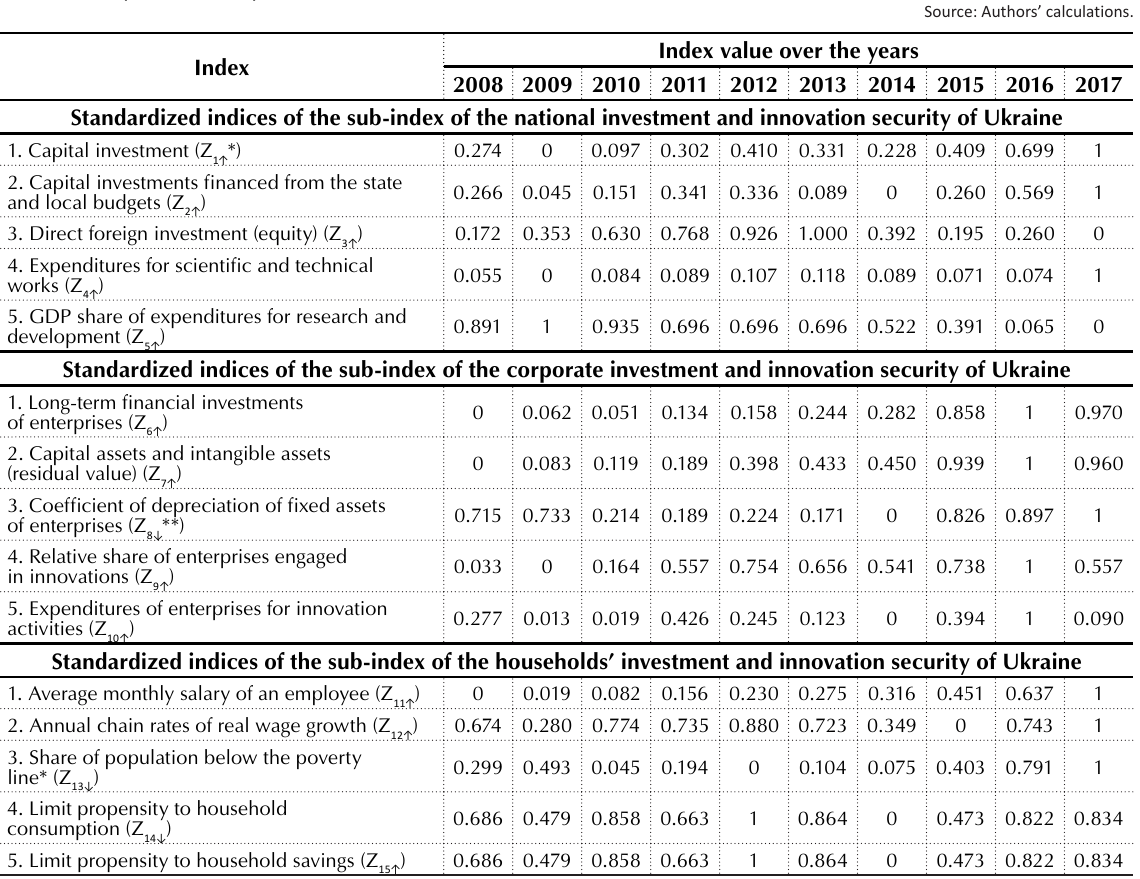
Table 6. Standardized single indices of the investment and innovation security sub-indices in Ukraine